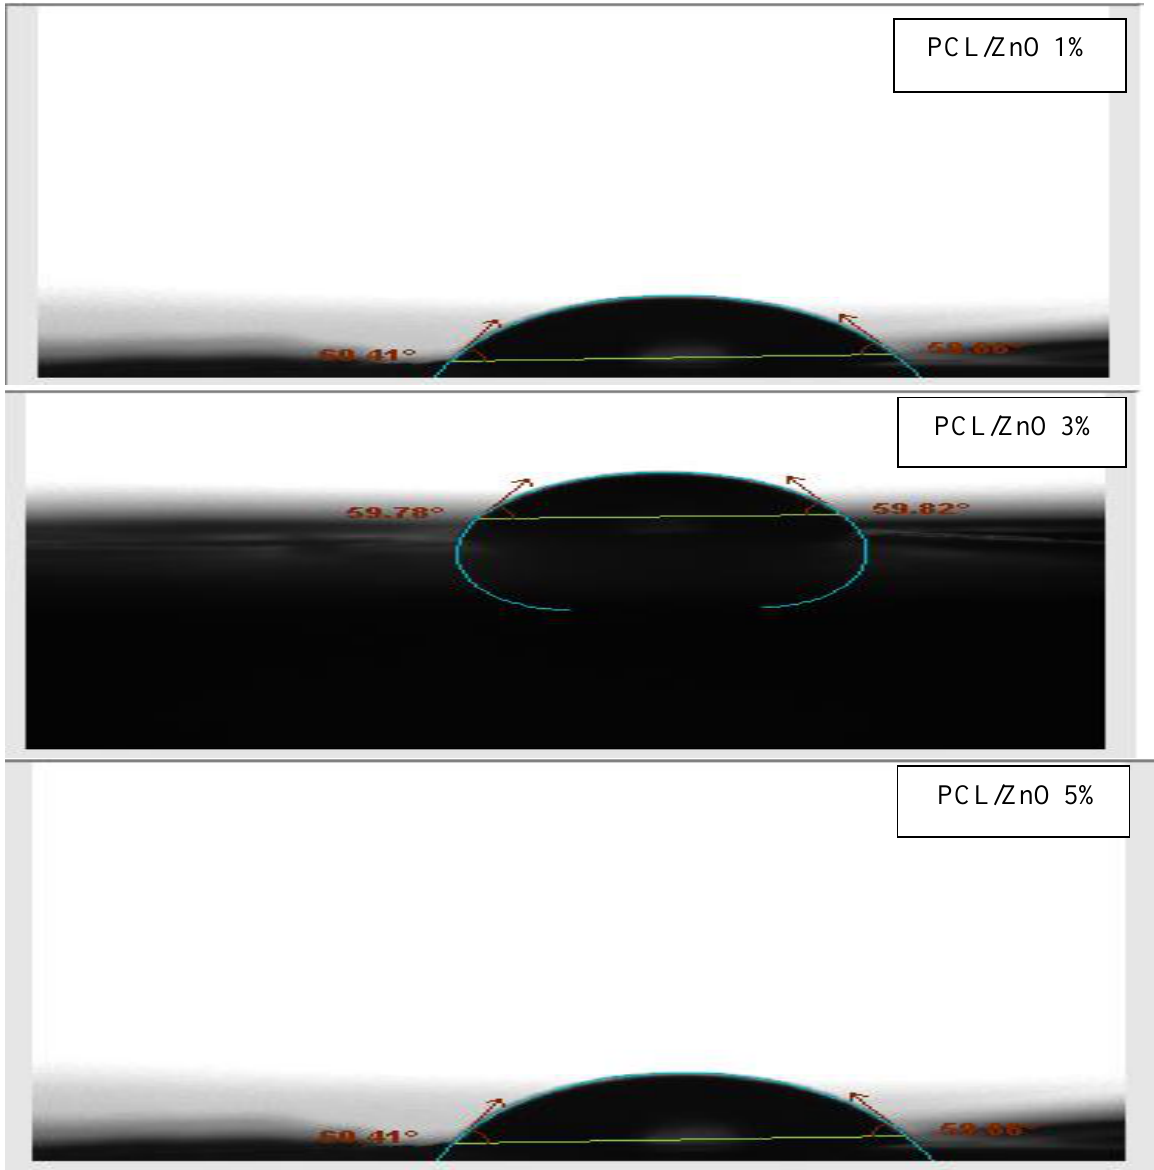
Fig.4: Contact angle test of pure PCL and PCL /ZnO nanocompositesat different concentration.